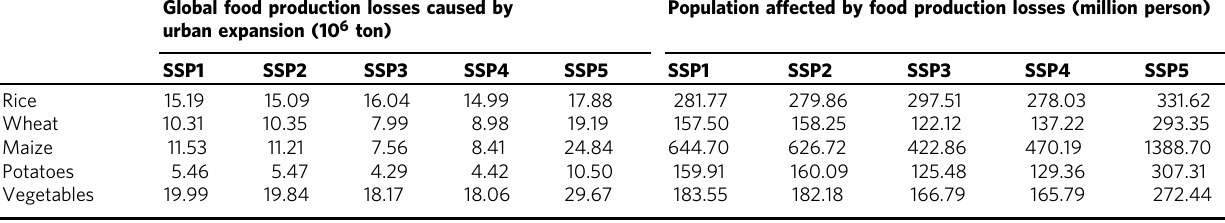
Table 2 Global food production losses caused by urban expansion by